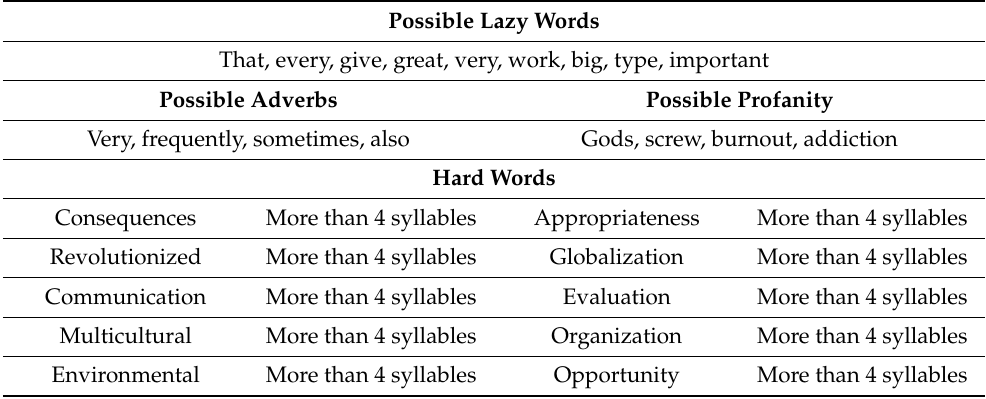
Figure 4. Word Length in Storyboarding (Source: Advanced Text Analyzer). The content of online activities showed complex words with longer syllables. For ex- ample, there were long sentences with more than 20 syllables across the online content. Table 7 summarizes this observation. Table 7. Word Statistics for Online Activity and Video Content (Source: Advanced Text